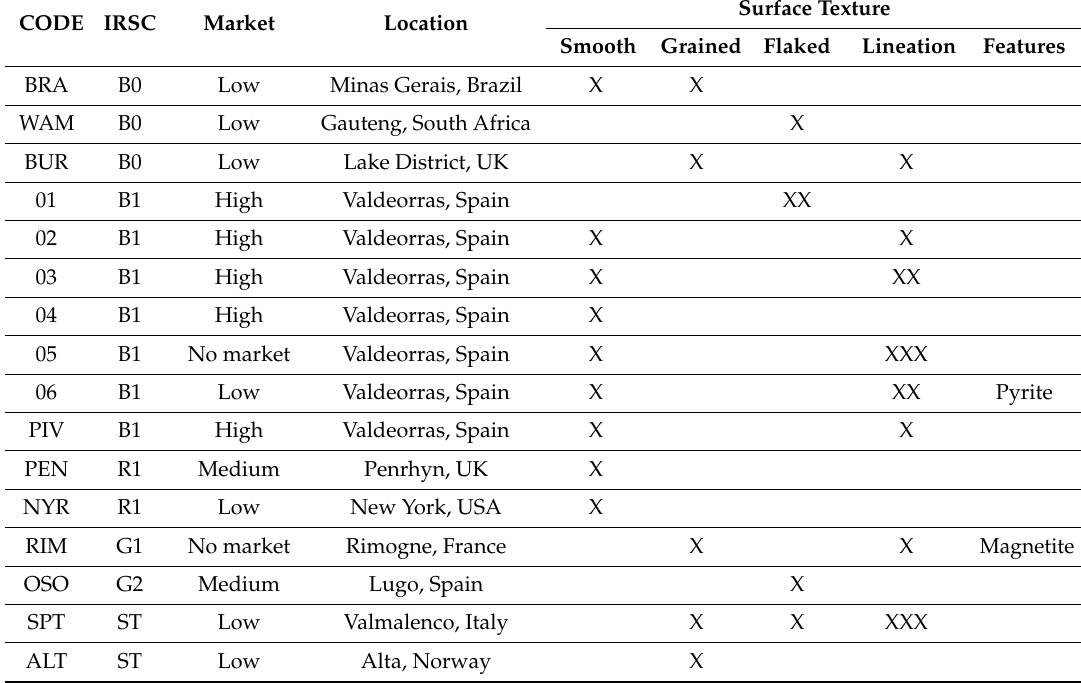
Table 1. Roofing slate samples. “Code / IRSC” refers to the lithotype according to the International Roofing Slate Classification. The letter is for color family (B: Black-grey; G: Green; and R: Purple-red), while the number is for rock type (0: Low-grade slate; 1: Slate; and 2: Phyllite). ST indicates other types of rock used as roofing slate. In this case, ALT is a quartzite, and SPT a serpentinite. “Market” represents the availability on the market. “High” indicates widely available roofing slates; “Medium” roofing slates which are available but scarce; “Low” scarce and special roofing slates that are only found in a restricted area; and “No market” is for roofing slates which are not sold at all. For the Surface Texture columns, blank space means no present, X low occurrence, XX medium occurrence and XXX high occurrence. Surface Texture CODE IRSC Market Location Smooth Grained Flaked Lineation